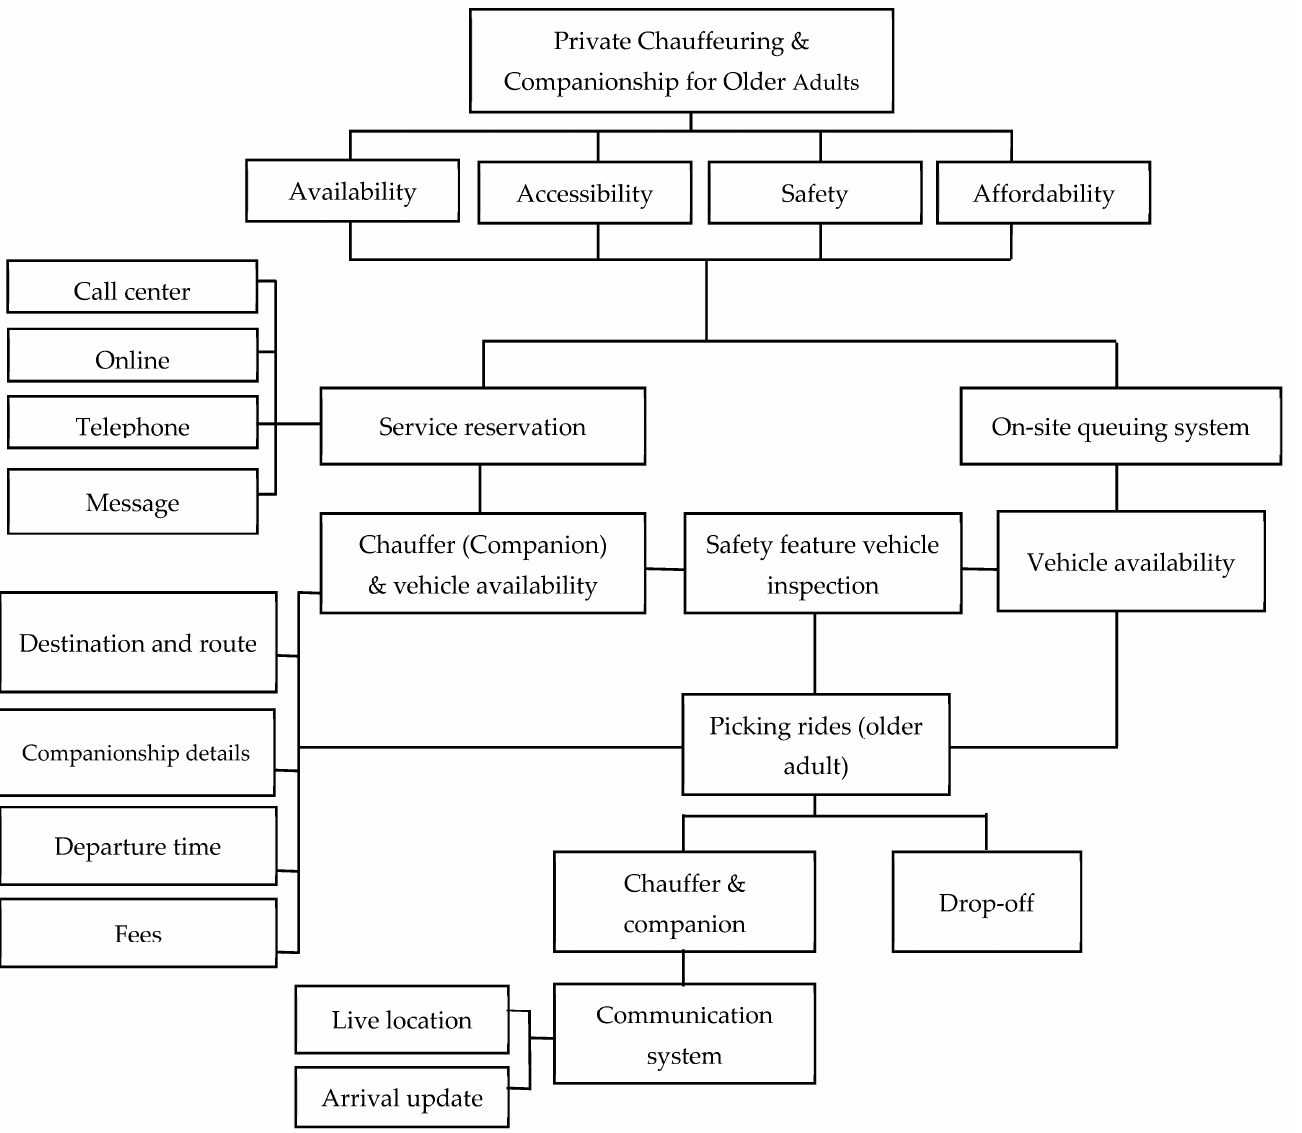
Figure 1. Private chauffeuring and companionship services for older adults. Note. Source: Authors, adapted from Wang and Shi [72].